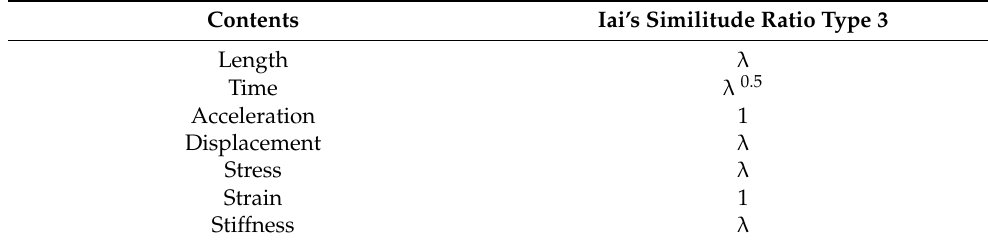
Table 2. Similitude law adopted in the model-based test [13].